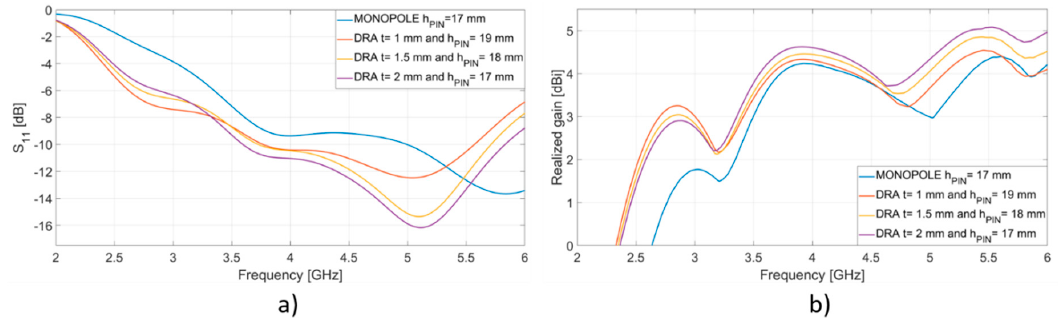
Figure 4. ( a ) Scattering parameter S 11 as the pin height h PIN is varied from 17 to 19 mm and the DRA thickness t is varied in the range 1–2 mm, h DRA = 29 mm; reference monopole antenna with a height of 17 mm is reported for comparison; ( b ) Realized gain as the pin height h PIN is varied in the range 17– 19 mm and the DRA thickness is varied in the range 1–2 mm, h DRA = 29 mm; reference monopole antenna with a height of 17 mm is reported for comparison.